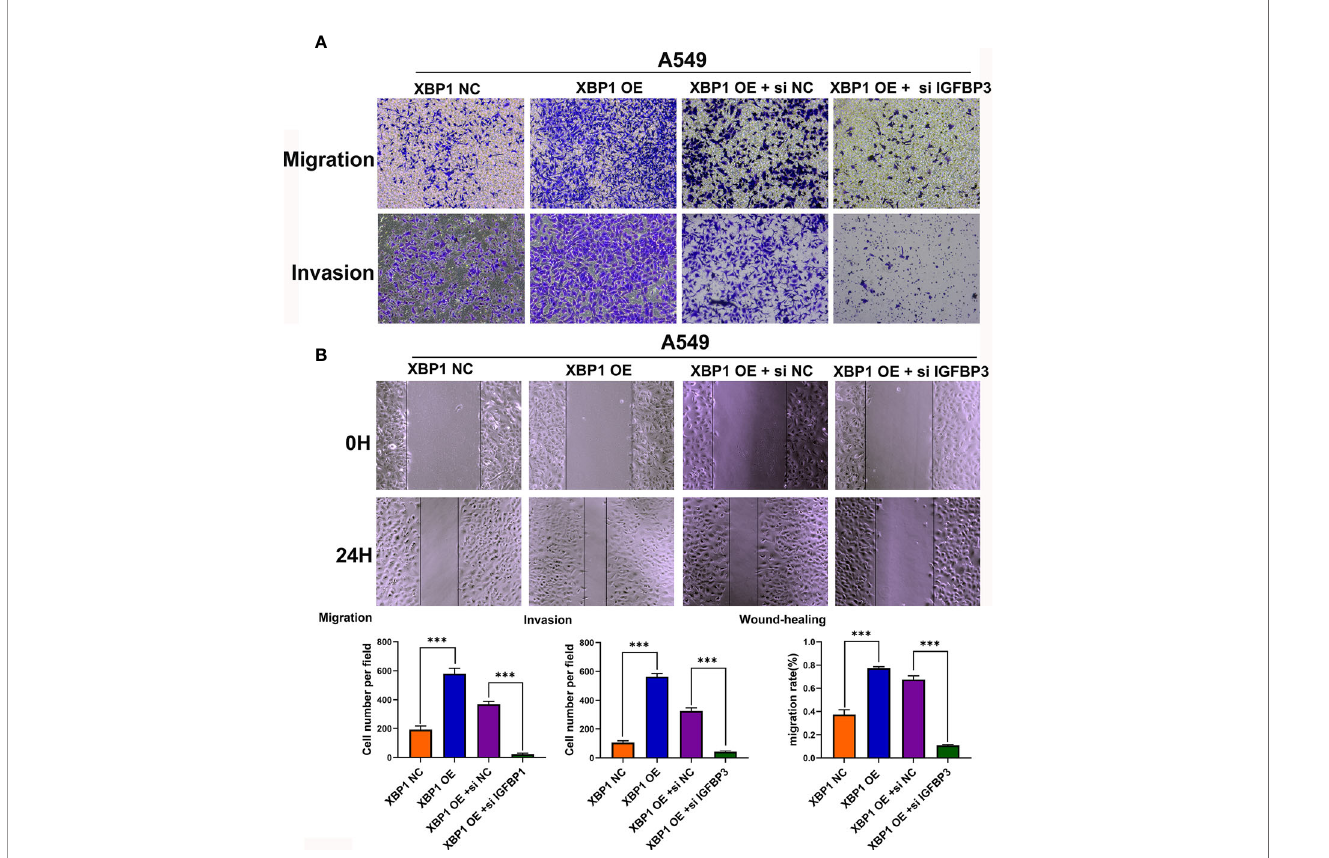
FIGURE 6 | IGFBP3 downregulation alleviates XBP1 induced lung cancer cells ’ migratory capacity and invasive ability in vitro . (A) Representative images and quanti fi cation of the transwell migration and invasion assay using transfected A549 cells. (B) Representative images and quanti fi cation of the wound-healing assay using transfected A549 cells. Data were represented as the mean ± SEM of three independent experiments. *** P <